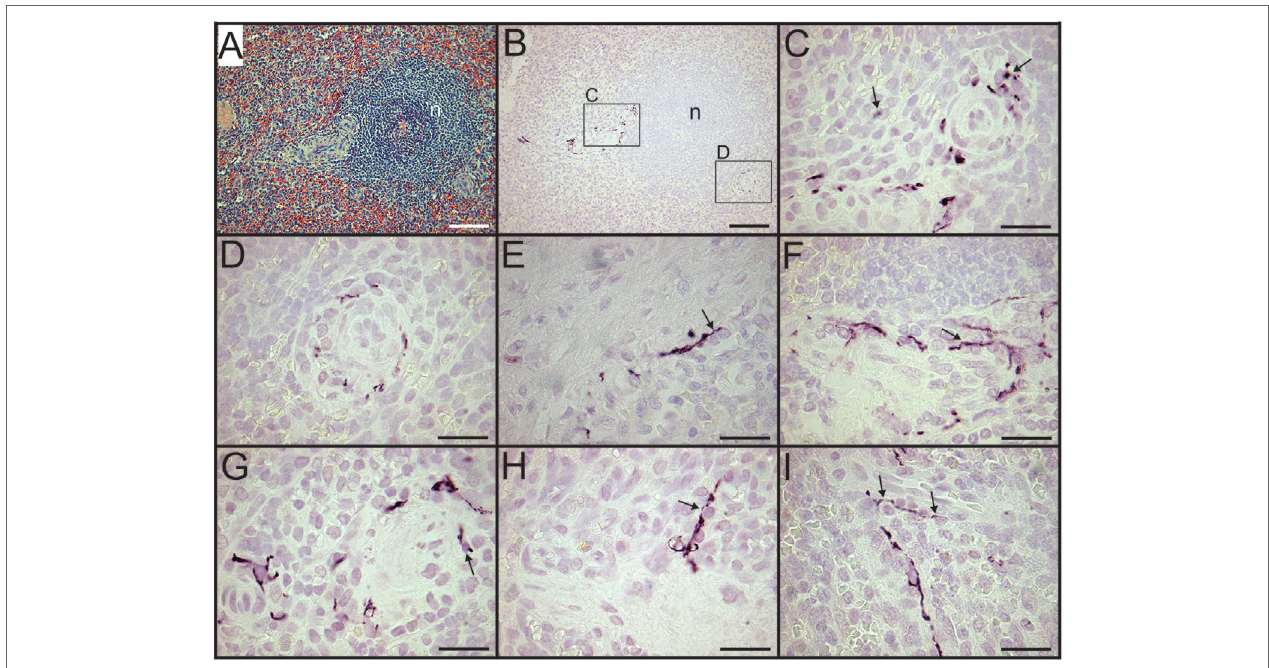
FigUre 2 | Sympathetic nerves in perivascular lymphatic tissue of control spleens have close association with leukocytes. (a,b) Hematoxylin and eosin stain of small arteries associated with a splenic nodule ( n ) in section from a trauma patient (a) and tyrosine hydroxylase (TH) + nerve fibers around same vessels in adjacent section (b) . Small boxes indicate regions shown at higher magnification (c,D) to demonstrate close apposition of sympathetic nerves with leukocytes. (e,F) Close apposition of sympathetic nerves with perivascular leukocytes (arrows) in spleen sections from female patients who were 74 and 57 years old, respectively. (g–i) Close apposition of TH + nerve processes with perivascular leukocytes (some indicated by arrows) in spleen section from another trauma patient. Scale bars: 100 µm (a,b) ; 25 µm (c–i)